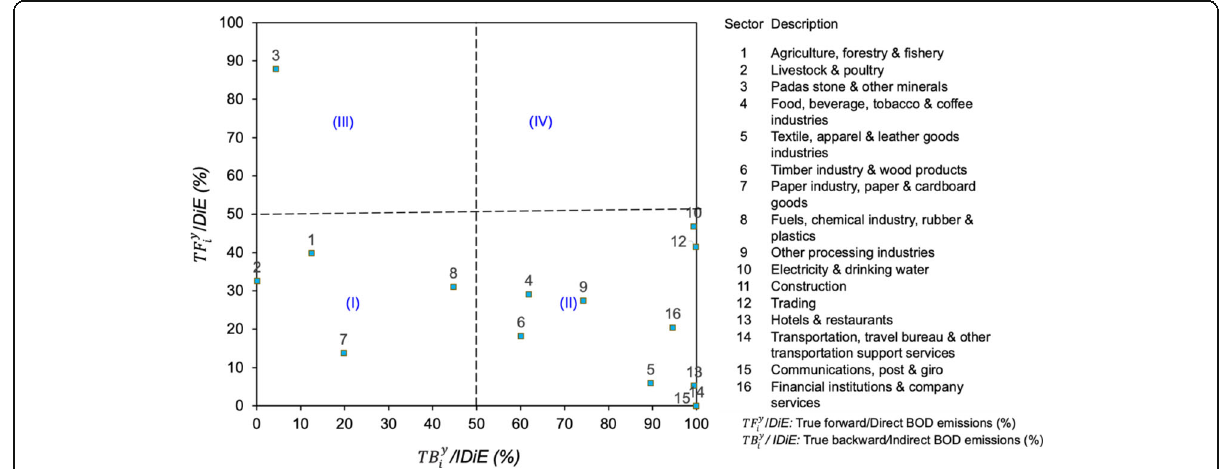
Fig. 6 Classification of sectors based on their BOD emissions